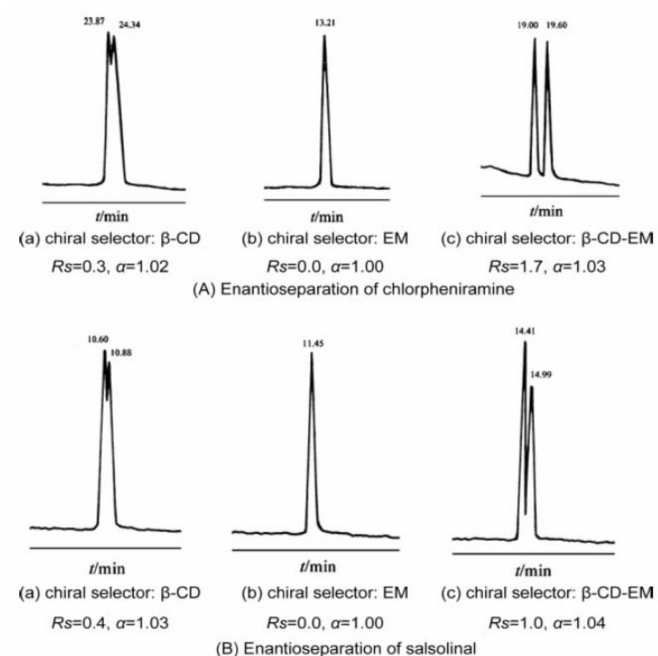
Figure 7. Enantio-separation of chlorpheniramine ( A ); and salsonilol ( B ) using β -CD, erythromycin (EM), and β -CD-derivatized erythromycin ( β -CD-EM) (CS concentration 15 mM). The figure is reproduced from Dai et al. [57] with permission from